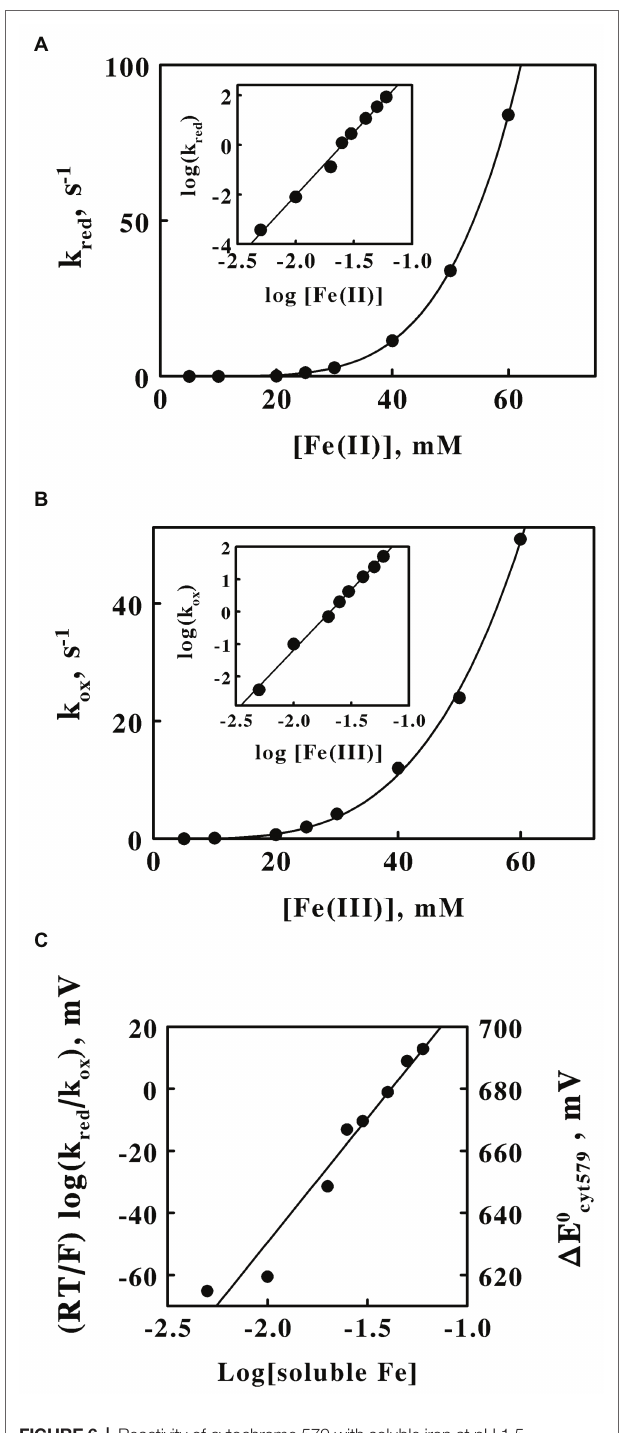
FIGURE 6 | Reactivity of cytochrome 579 with soluble iron at pH 1.5. Absorbance changes were monitored in a stopped flow spectrophotometer when the purified cytochrome was rapidly mixed with a molar excess of soluble iron. (A) Dependence of the pseudo-first order rate constant for the reduction of oxidized cytochrome 579 on the concentration of ferrous ions. Final concentrations after mixing: cytochrome 579, 8.6 μ M; and sulfuric acid, 0.02 M. The curve drawn through the data points was proportional to the concentration of ferrous ions raised to the power of 5.0. Inset , the dependence of the logarithm